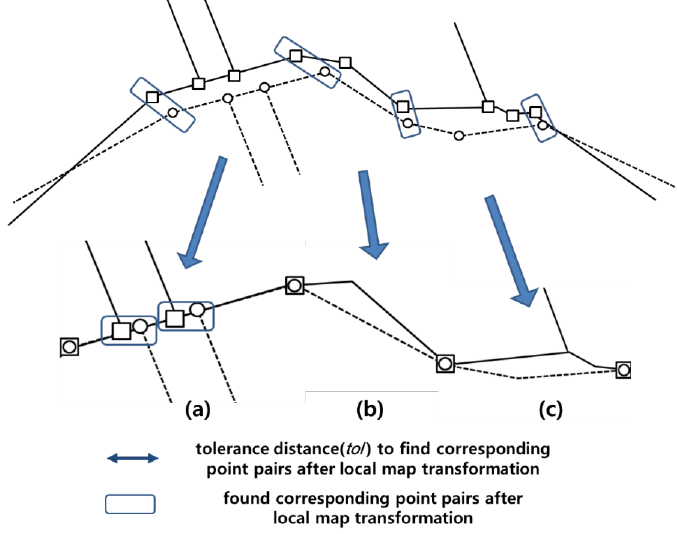
Figure 6. Local map transformation of corresponding sub-point string pair; ( a ) two corresponding point pairs are found after transformation, ( b,c ) no additional corresponding point pairs are found and there remain spatial inconsistences after transformation.